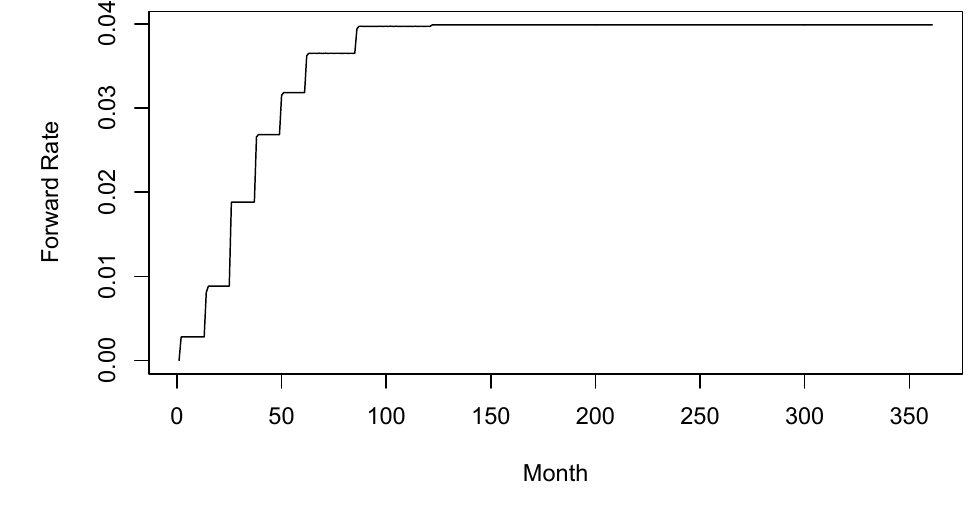
Figure 1: The monthly forward rates bootstrapped from the swap rates given in Table